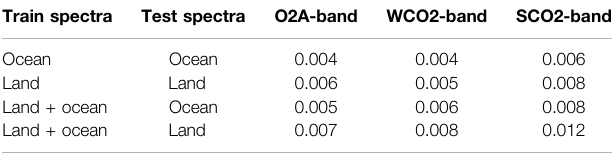
TABLE 3 | Modeling error in percent relative to continuum for models trained with land nadir and ocean glint soundings. The last two rows show the performance for the models fi t with a mix of land and ocean (as